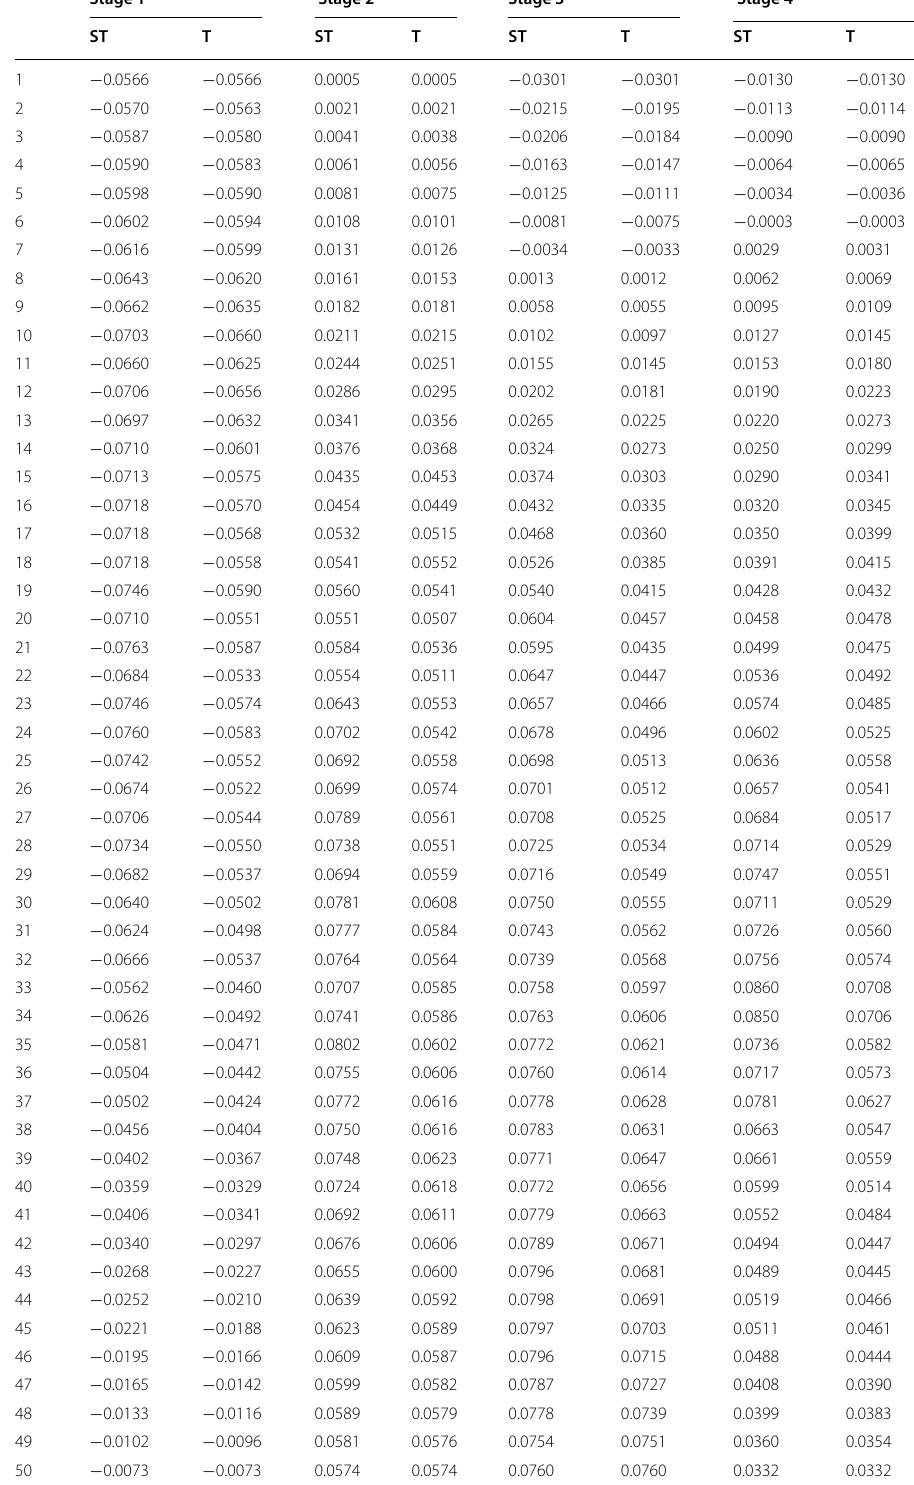
Table 5 Sharp ratios of portfolio with different